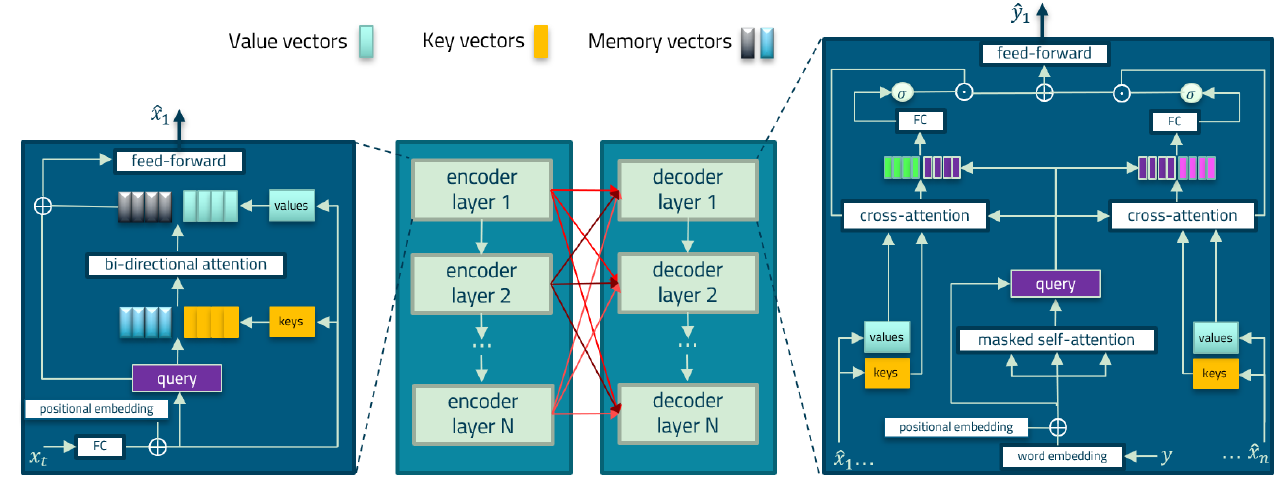
Figure 3. The architecture of both the teacher model and the student model. It consists of a stack of memory-augmented encoders and a stack of meshed decoders. The memory-augmented encoder encodes the multi-level visual relationships leveraging the priori knowledge provided by the memory vectors. The meshed decoder generates the textual tokens leveraging the meshed connectivity illustrated by the red